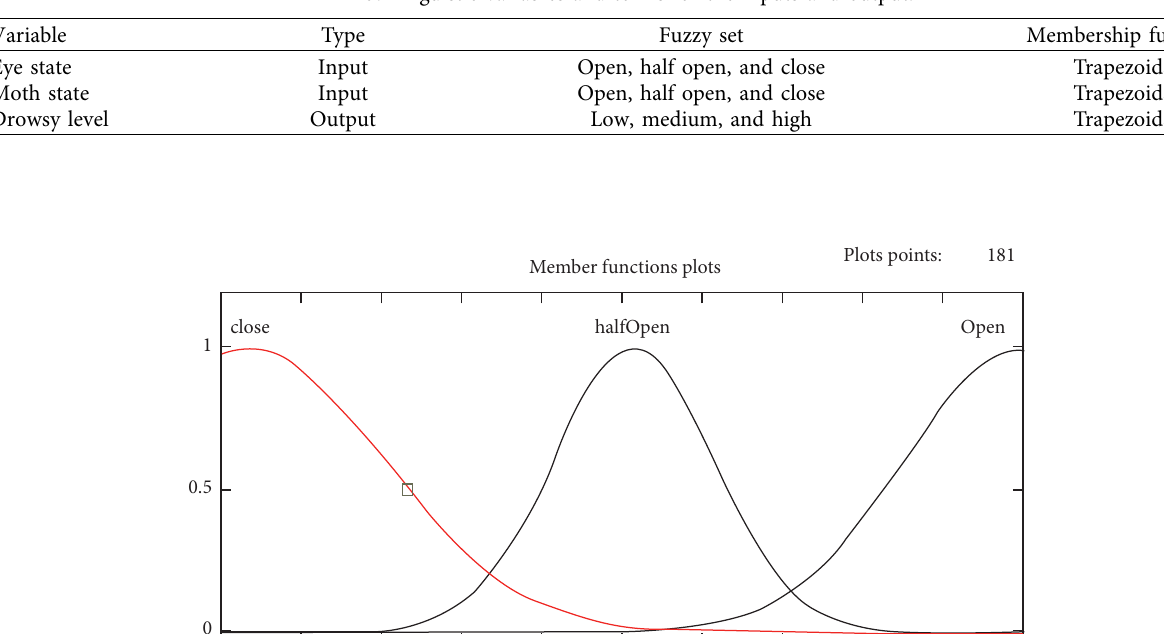
Table 3: Linguistic variables and terms for the inputs and